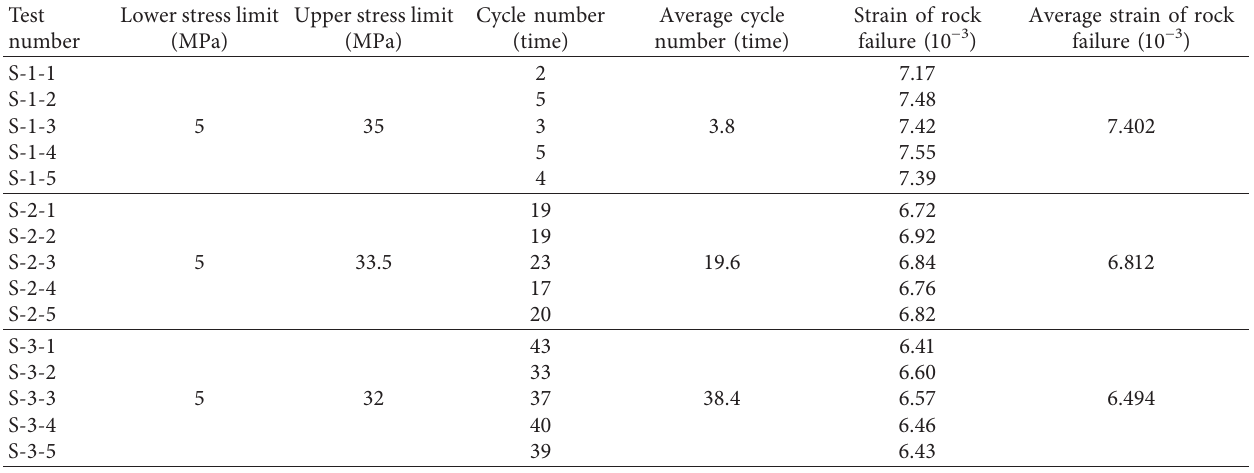
Table 2: Test results of rock samples under uniaxial cyclic loading and unloading.